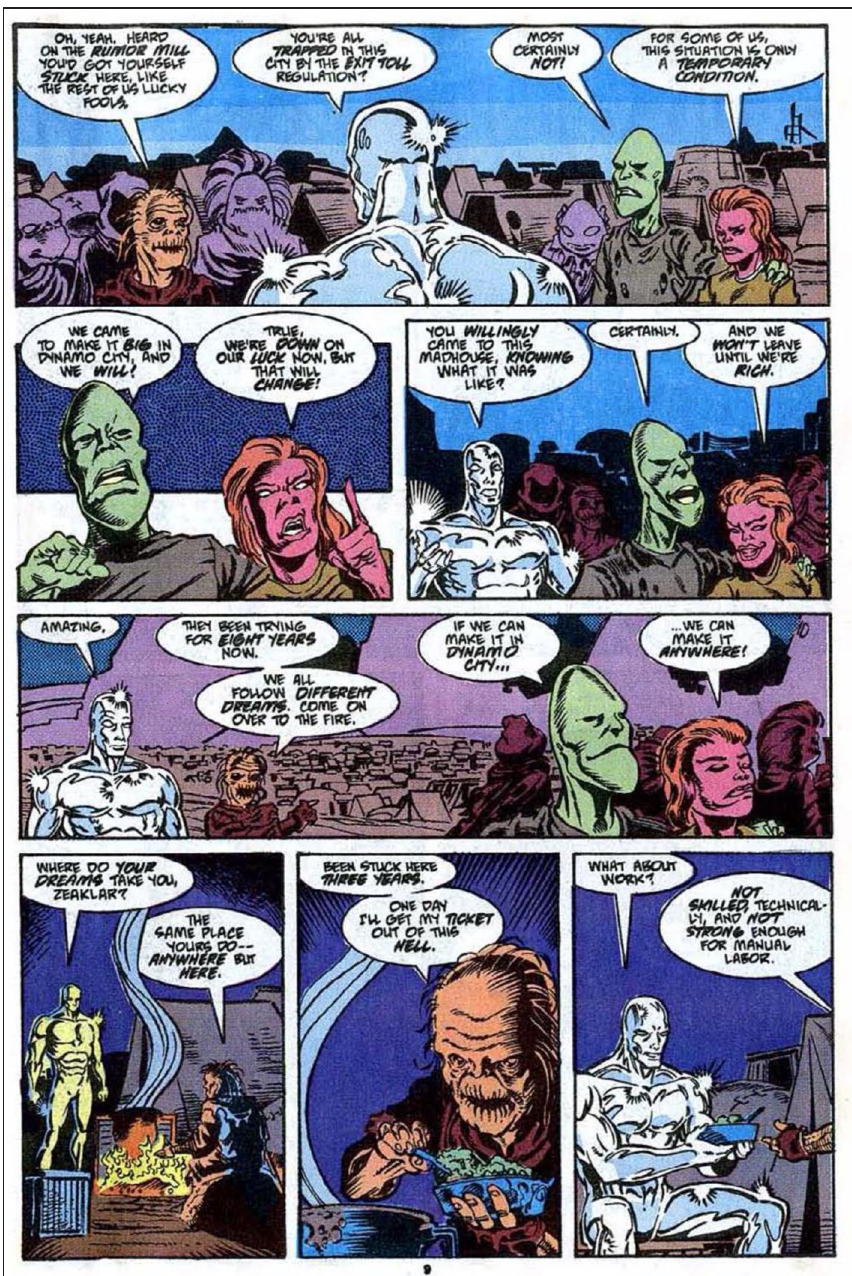
Figure 3: The Silver Surfer #41. New York: Marvel, 1990, p. 9. Jim Starlin (writer), Ron Lim (penciler), Tom Christopher (inker), Ken Bruzenak (letterer), Tom Vincent (colorist), Craig Anderson (editor), Tom Defalco (Chief). © 1990 Marvel Entertain- ment Group,